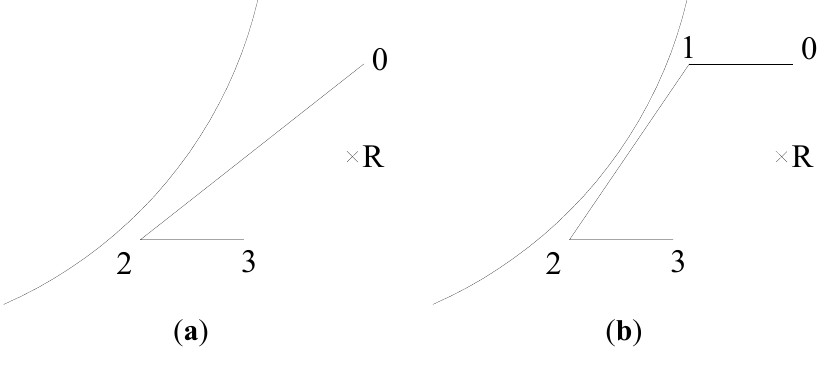
Figure 10. The psychrometric processes: ( a ) conventional system; ( b ) The proposed HPHX-DX